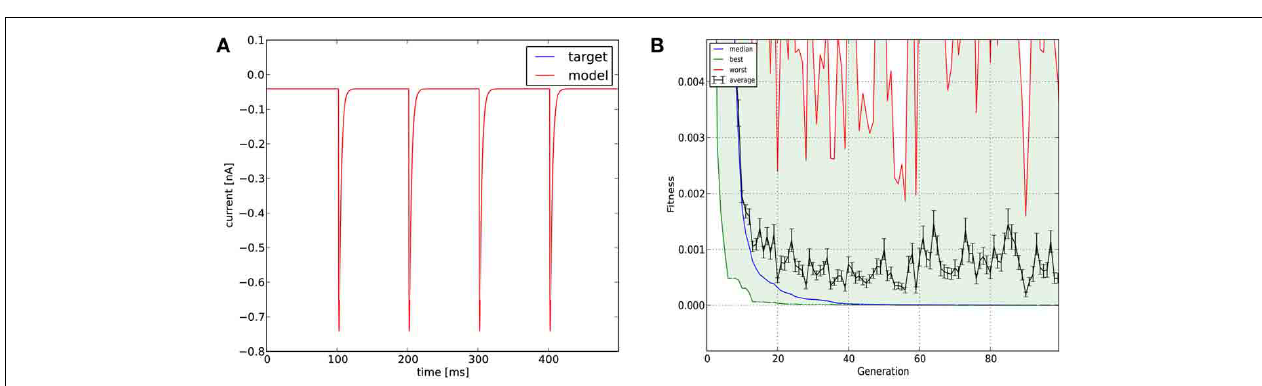
trace (red). Further details of the spike shape are shown in Figure 9 . (B) Evolution of the lowest and median error value across generations in the evolutionary algorithm.